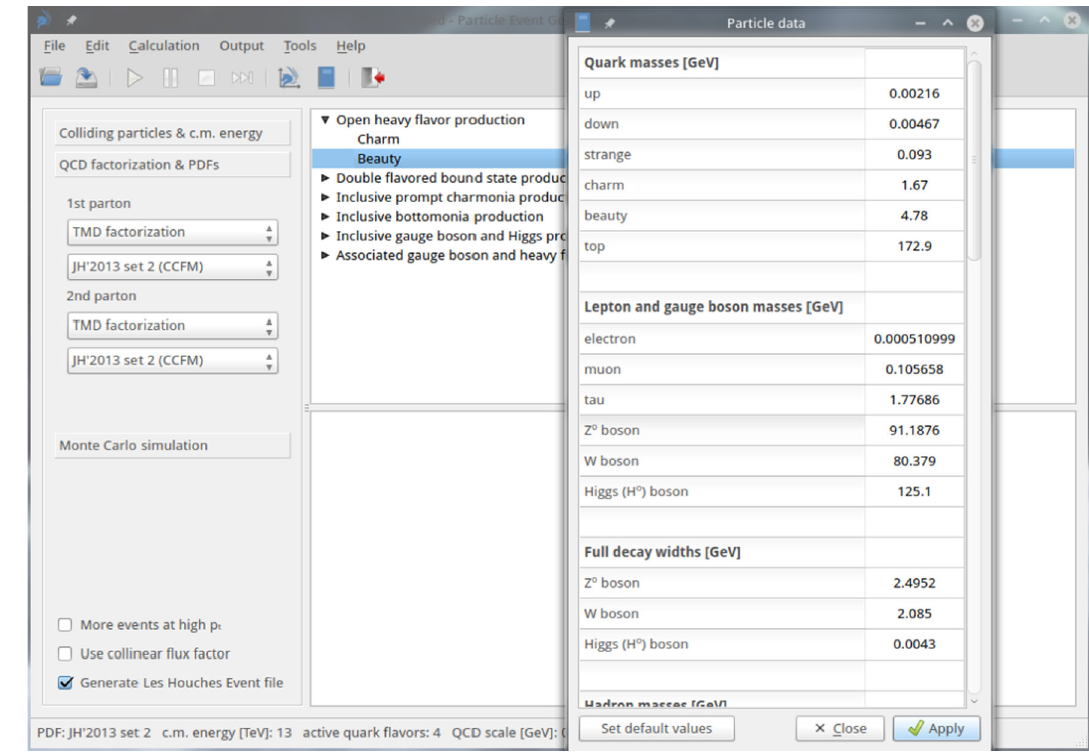
Fig. 5 Particle data tool can be launched from pegasus main window